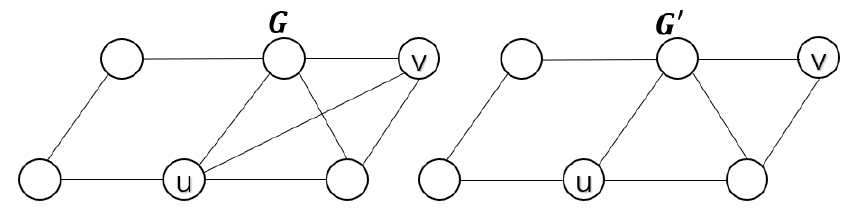
Figure 7. G (cid:48) is obtained from G by removing the edge ( u , v ) .